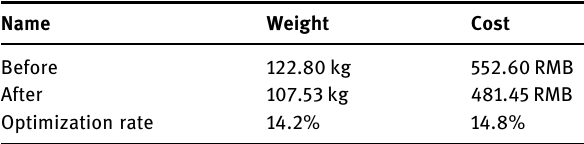
Table 10: Final optimization results of mass and cost Name